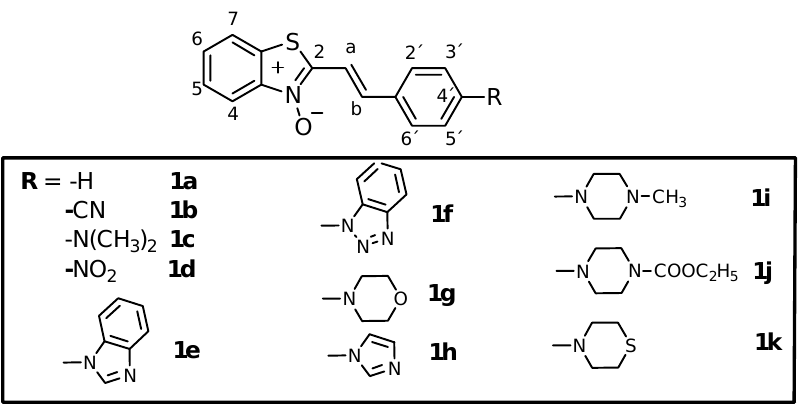
Figure 1. Structure of target benzothiazole- N